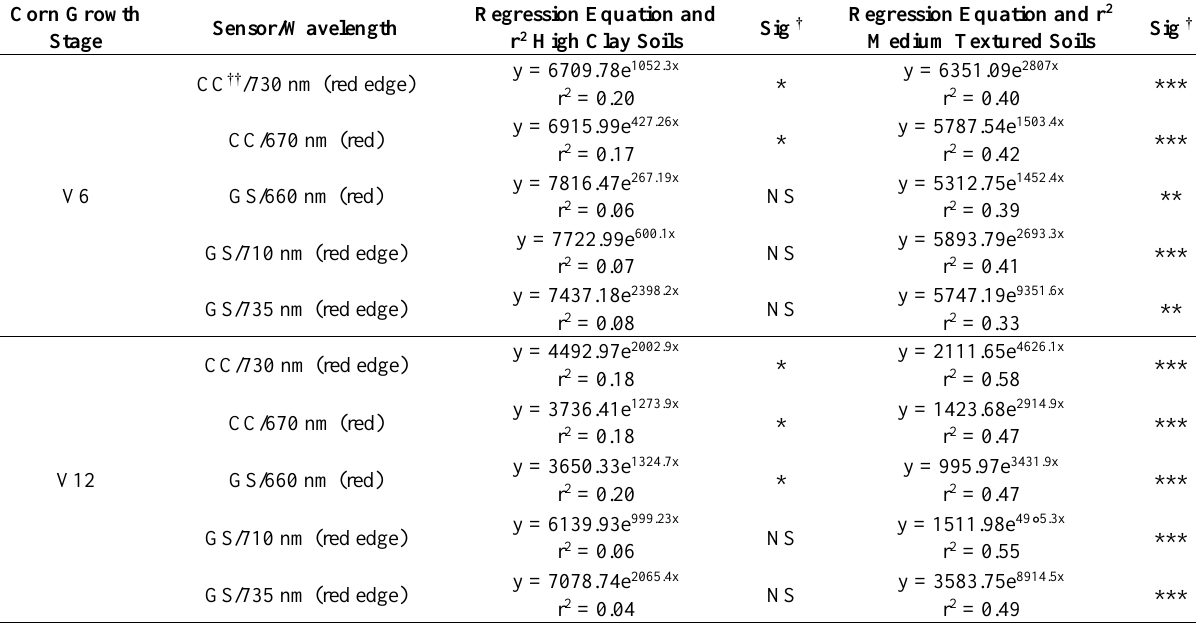
Table 4. Exponential regression equations for Yield and INSEY for five wavelengths of two ground-based active-optical sensors under high clay ( n = 143) and medium textured conventional-till ( n = 71) sites at V6 and V12 corn growth stages. Corn Growth Regression Equation and Sensor/Wavelength Stage r 2 High Clay Soils